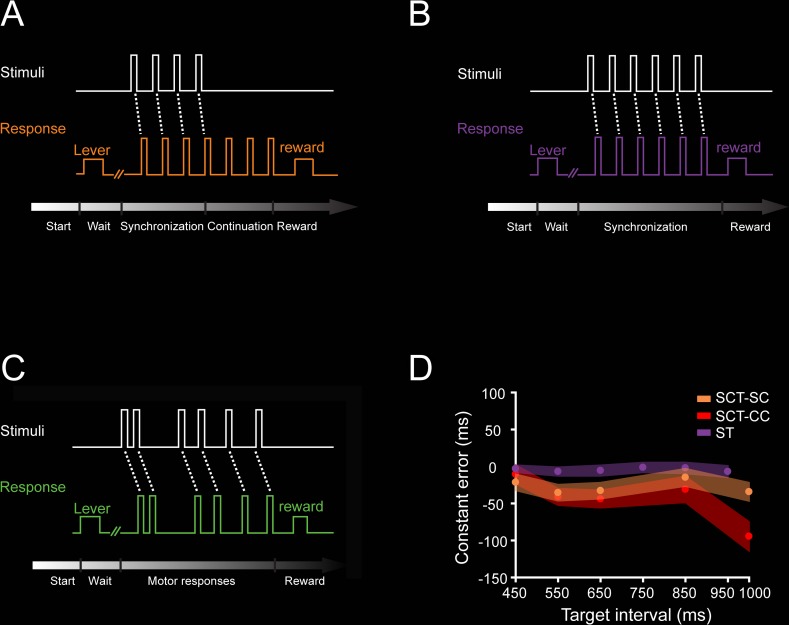
Tasks.A. SCT. The trial started when the monkey placed his hand on a lever for a variable delay. Then, a visual metronome was presented, and the monkey tapped on a button to produce three intervals of a specific duration following the isochronous stimuli (synchronization phase), after which the animal had to maintain the tapping rate to produce three additional intervals without the metronome (continuation phase). Correct trials were rewarded with an amount of juice that was proportional to the trial length. The instructed target intervals were 450, 550, 650, 850, and 1,000 ms. B. ST. Similar to the synchronization phase of the SCT, the animal had to produce five intervals guided by a visual metronome. The instructed intervals were 450, 550, 650, 750, 850, and 950 ms. C. SRTT. As in ST, the trial started when the monkey placed its hand on a lever for a variable delay. However, in this task, the monkey tapped the button after six stimuli separated by a random interstimulus interval, precluding the temporalization of the tapping behavior. D. Constant error (mean ± SD/2) as a function of target interval during the SC (orange) and CC (red) of the SCT (ANOVA main effect interval, F(4, 1,112) = 61.01, p < 0.0001; main effect task condition, F(1, 1,112) = 43.16, p < 0.0001; interval × condition interaction, F(4, 1,112) = 17.66, p < 0.0001), and the ST (purple) as a function of target interval (ANOVA for 450, 550, 650, and 850 target intervals between SC of the SCT and the ST, main effect interval, F(3, 631) = 4.18, p < 0.01; main effect condition, F(1, 631) = 202.16, p < 0.0001; nonsignificant interval × condition interaction, F(3, 631) = 2.46, p = 0.06). Underlying data are available in https://doid.gin.g-node.org/d315b3db0cee15869b3d9ed164f88cfa/. CC, continuation condition; SC, synchronization condition; SCT, synchronization-continuation task; SRTT, serial reaction time task; ST, synchronization task.